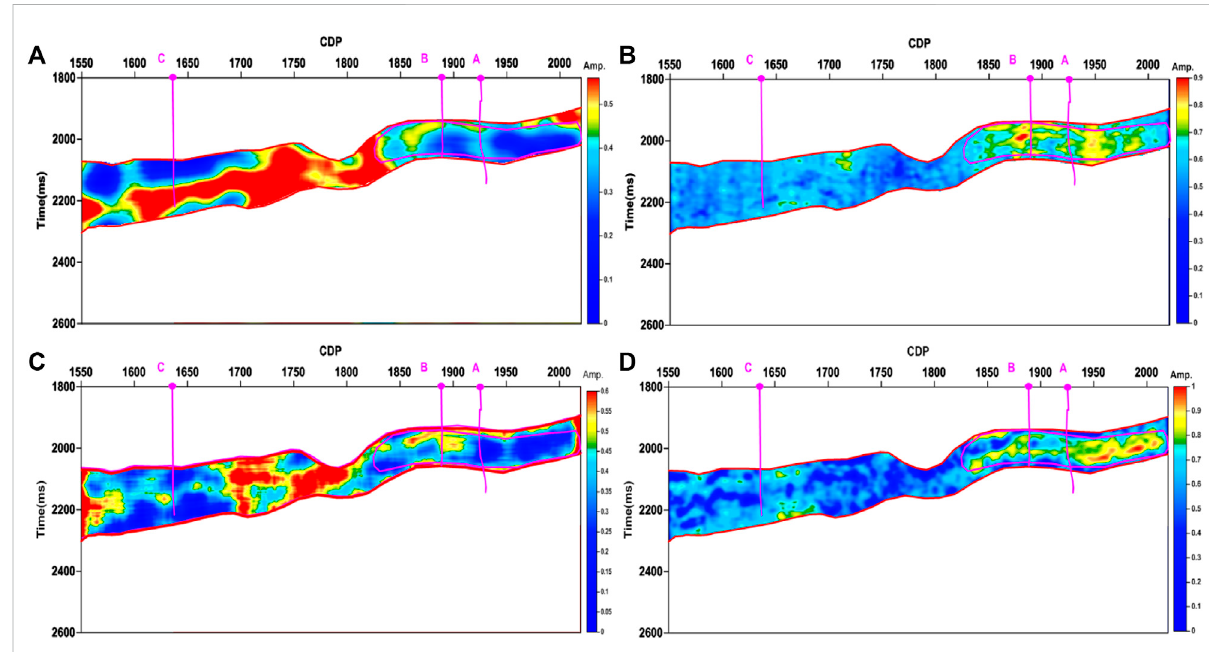
FIGURE 11 The absorption gradient sections using the different methods. (A) The conventional absorption gradient section using the continues WT (CWT) and the two-point slope estimation. (B) The absorption gradient section using VMD and LSF at a high-frequency band. (C) The